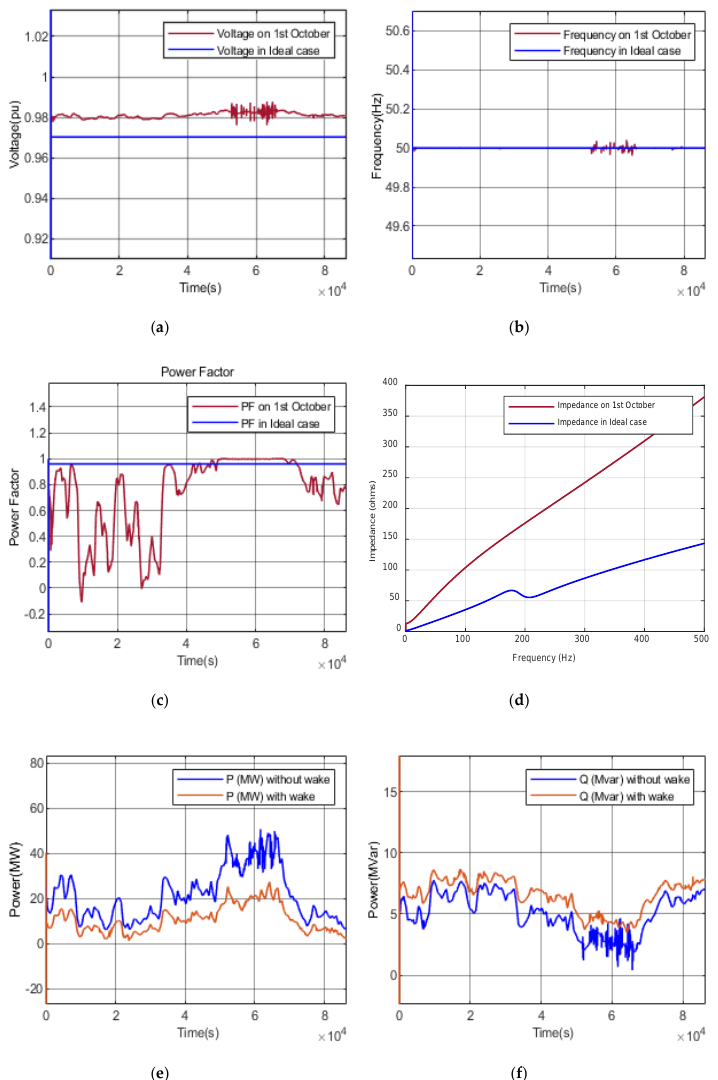
Figure 8. Case-1, Scenario 5: ( a ) Voltage (V) at PCC; ( b ) frequency (F) at PCC; ( c ) PF at PCC; ( d ) Impedance (Z) vs. F; ( e ) P-trend; and ( f )